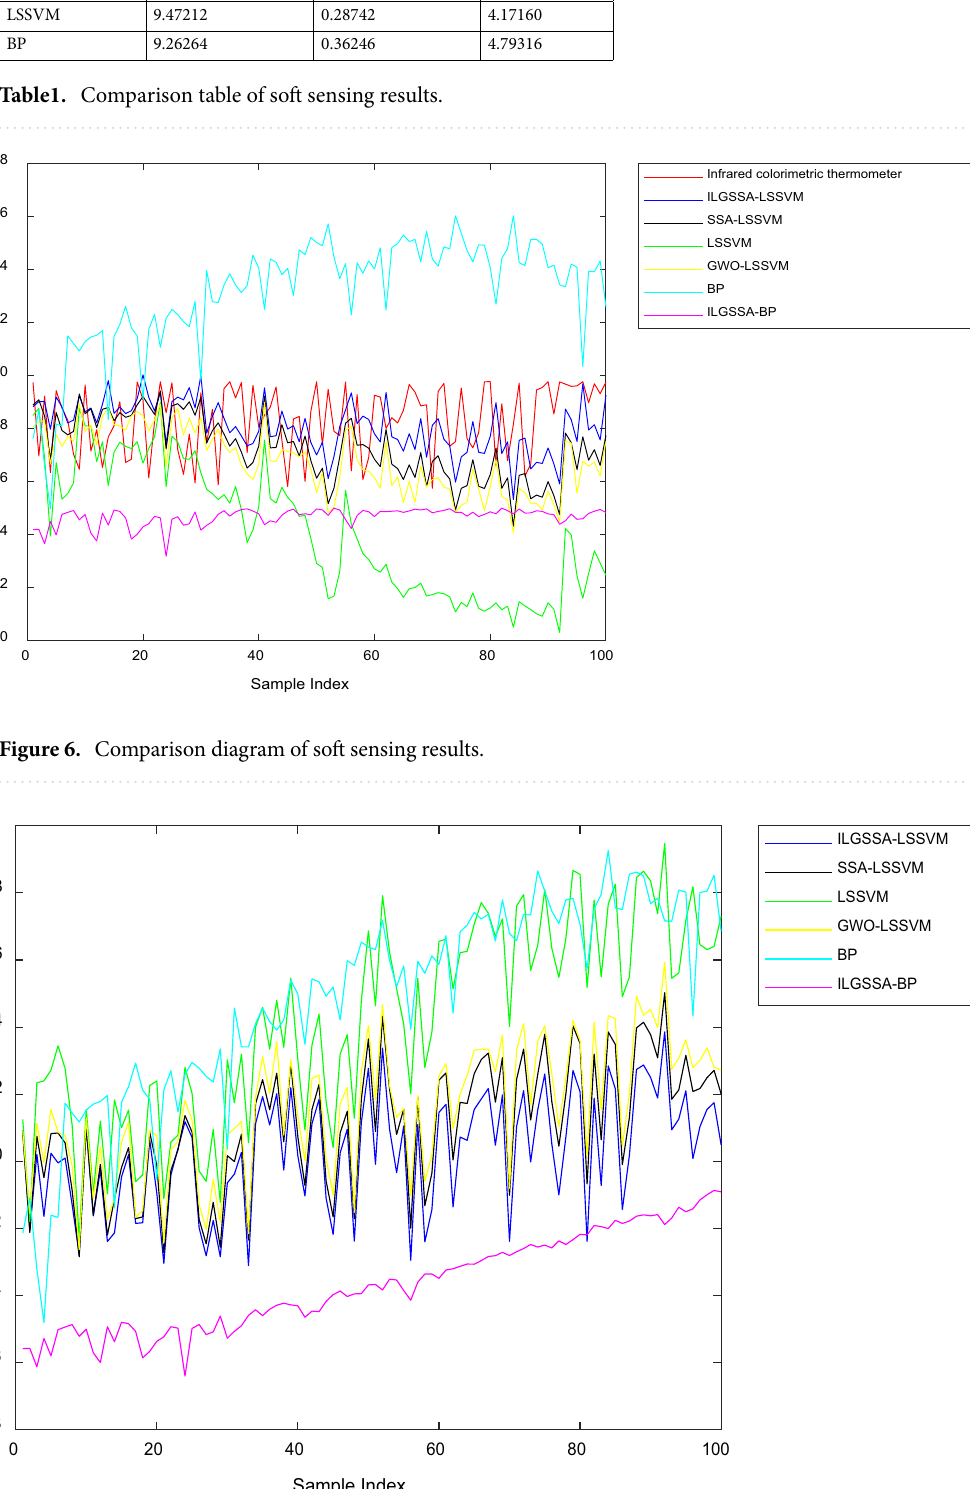
Figure 7. Comparison diagram of errors of various soft sensing